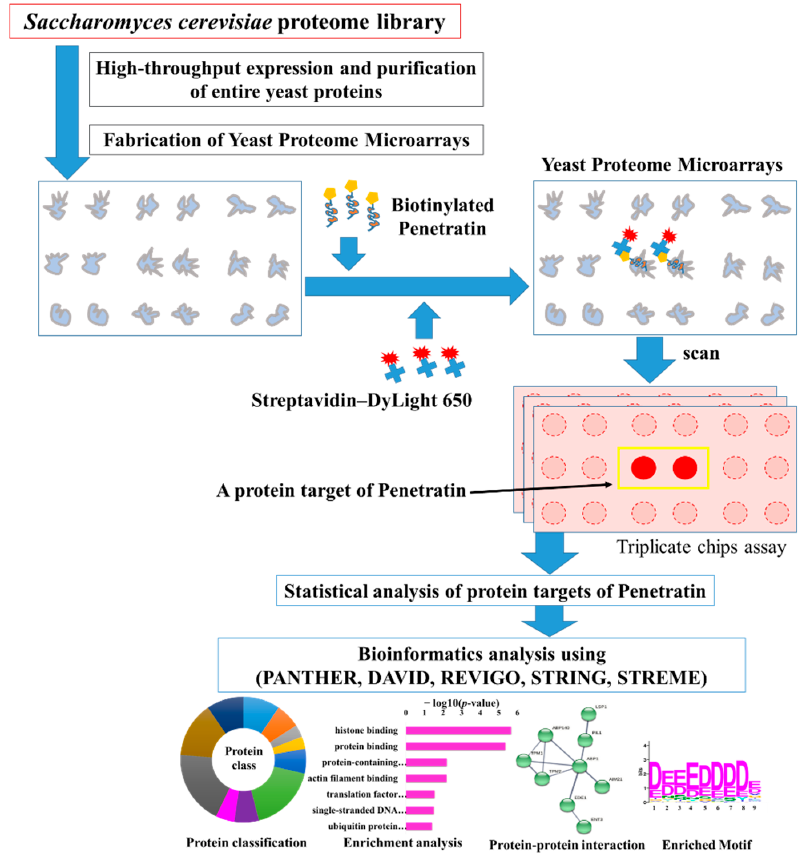
Figure 1. Schematic diagram of this study. For the screening of the protein targets of penetratin, biotinylated penetratin was probed on yeast proteome microarrays followed by streptavidin-DyLight 650 and anti-His antibody-DyLight 550. For simplicity, His tag and anti-His antibody signal of the yeast protein are not shown. The yeast proteome microarrays were scanned and the interact- ing signals of penentratin with yeast proteins partners were obtained. Data from triplicate yeast